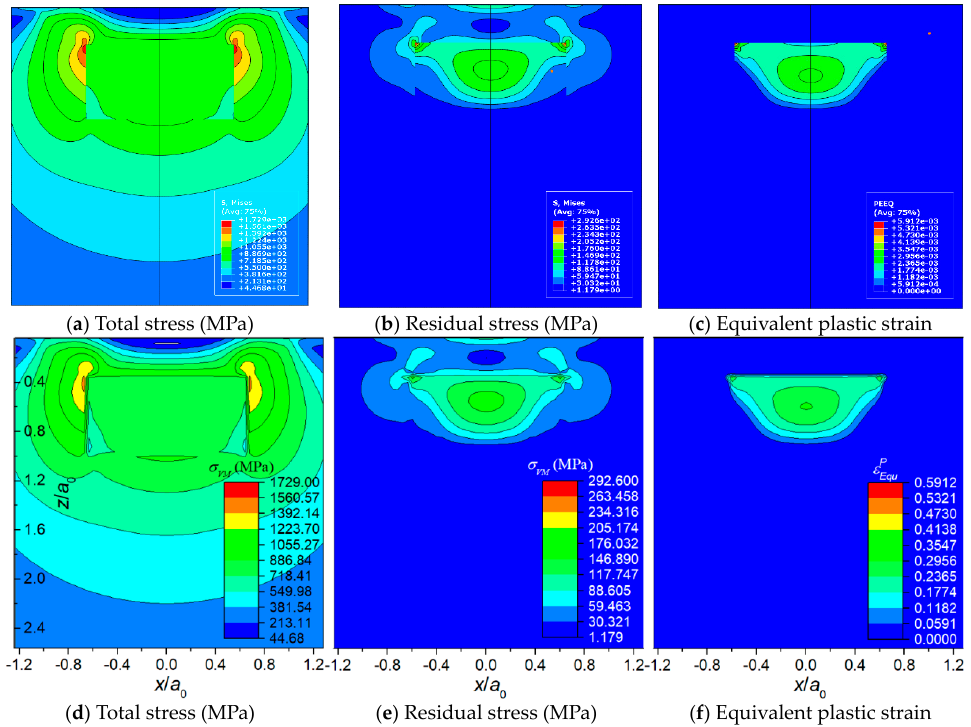
Figure 9. Case 2: The inhomogeneity is compliant and elasto-plastic while the matrix material is elastic. ( a – c ) results of FEM and ( d – f ) results of SAM.